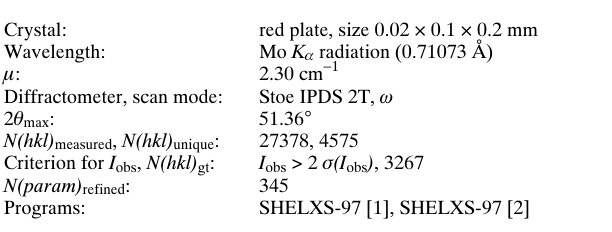
Table 1. Data collection and handling.